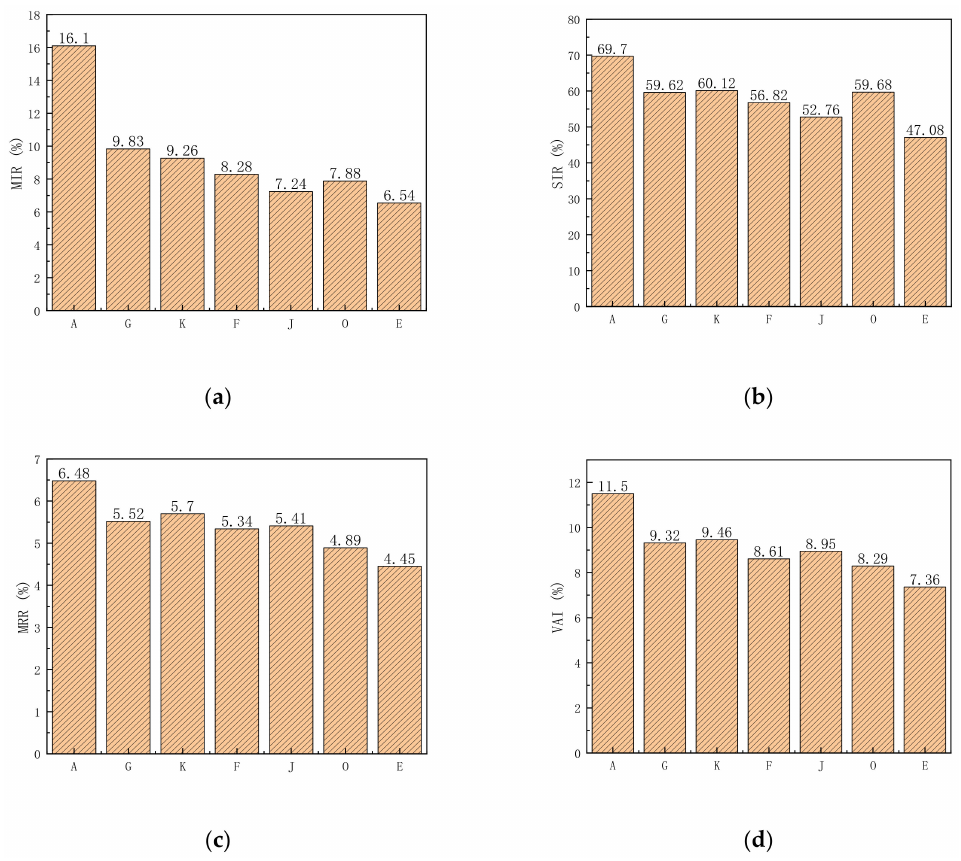
Figure 10. Ultraviolet aging resistance indexes of asphalt of different schemes: ( a ) complex shear modulus increasing ratio (MIR); ( b ) creep stiffness increase ratio (SIR); ( c ) creep rate reduction ratio (MRR); ( d ) viscosity aging index